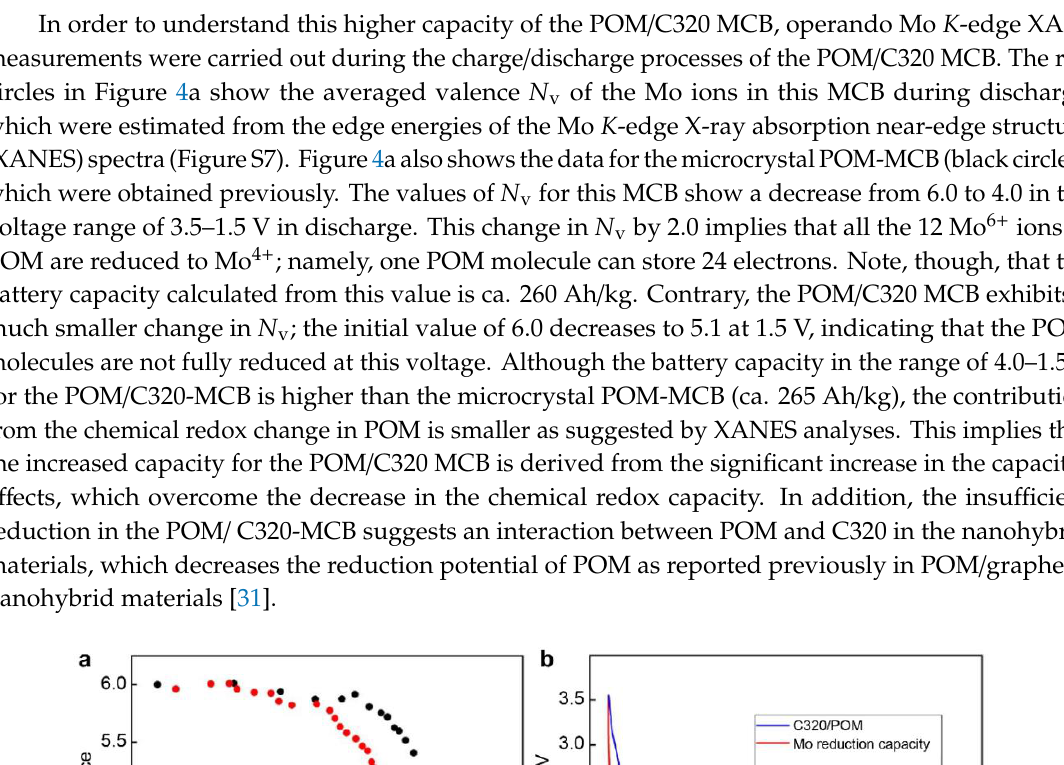
Figure 3. First discharge and second charge curves in the voltage range of 1.5–4.2 V with a constant current of I = 1.0 mA for ( a ) POM/CMK-3, ( b ) POM/C320, ( c ) POM/C500, ( d ) POM/C642. ( e ) Cycle performance for POM/CMK-3, POM/C320, POM/C500, and POM/C642.